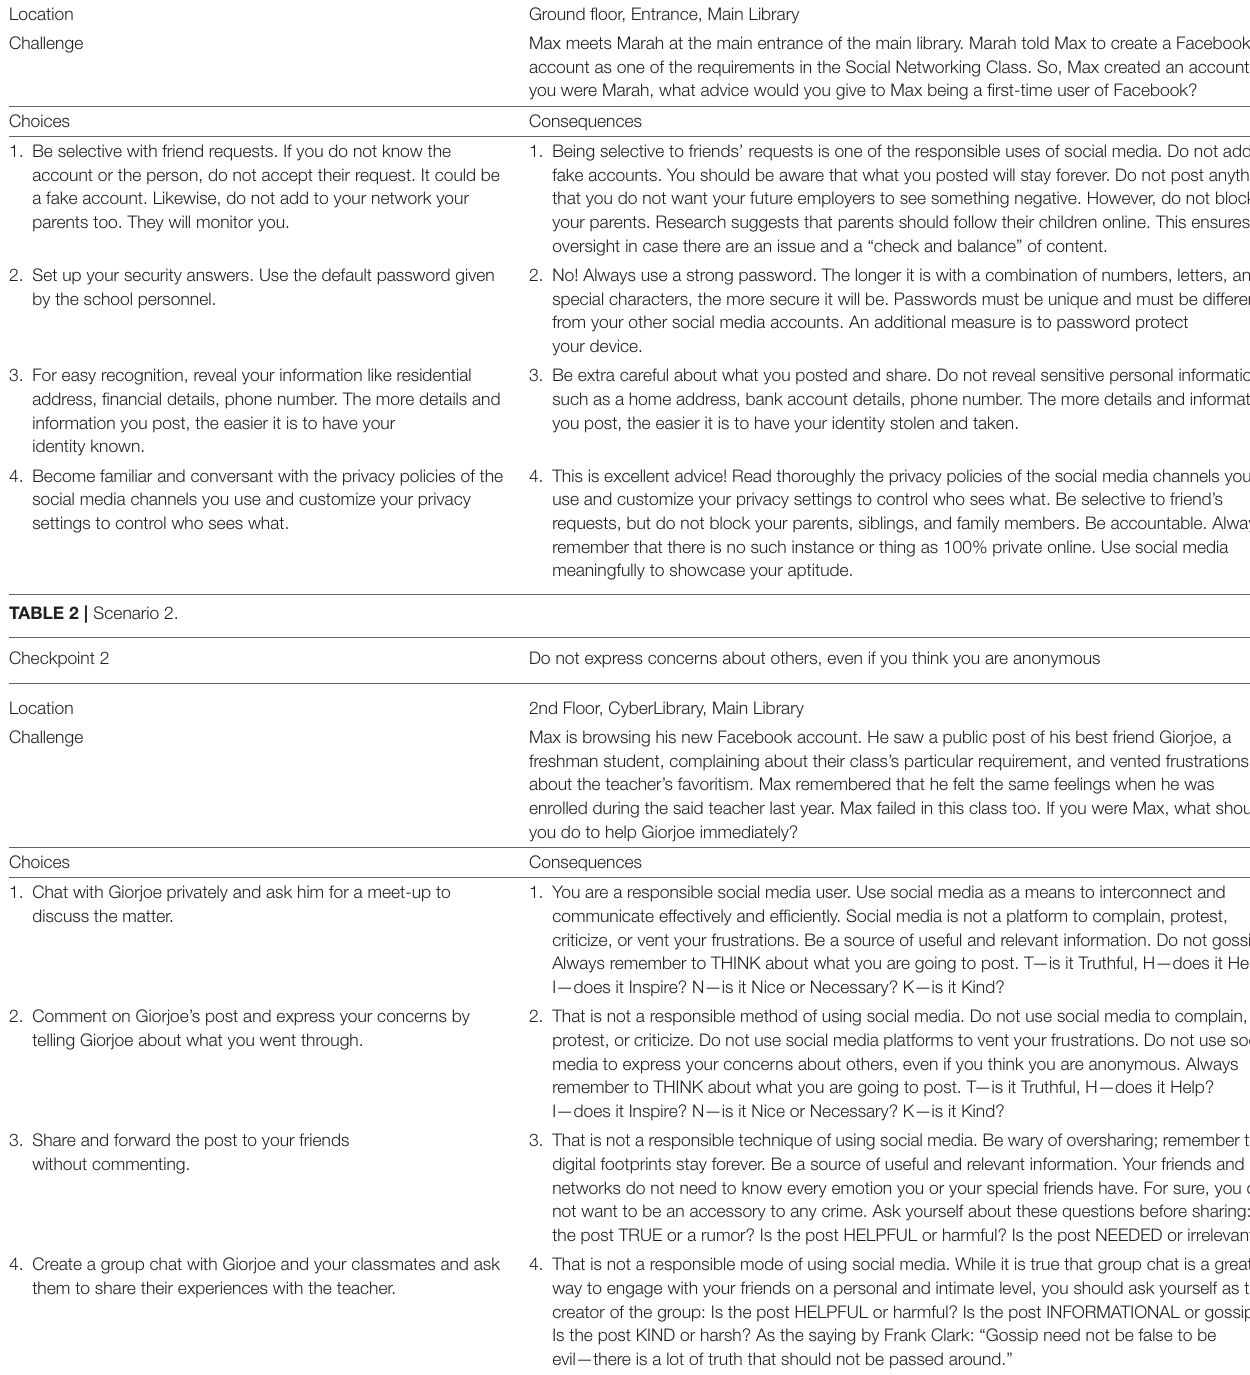
TABLE 1 | Scenario 1. Checkpoint 1